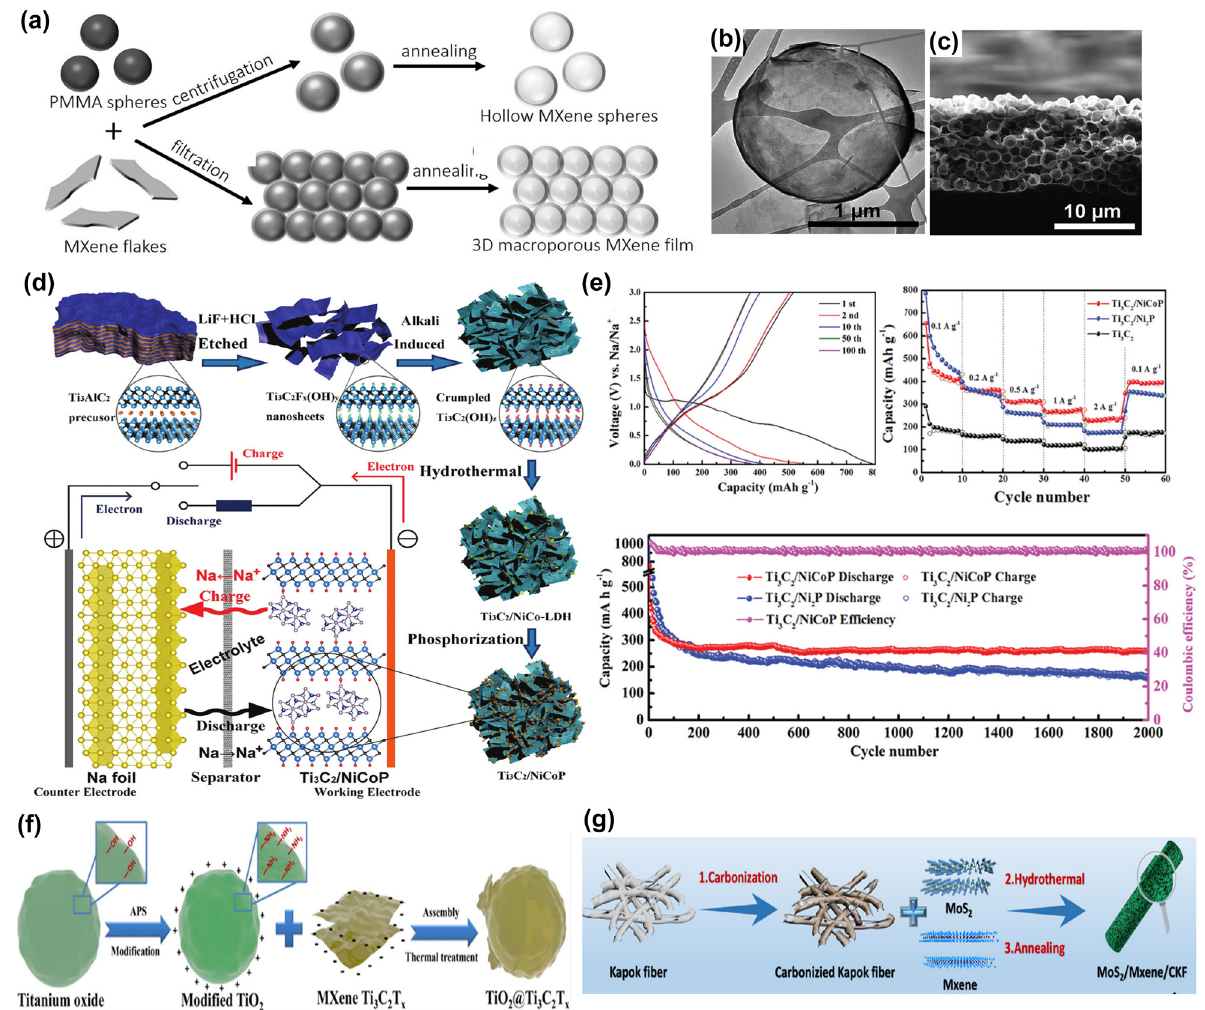
Figure 6: Preparation process, structure and electrochemical performance of MXene composites anode for SIBs. (a) Schematic showing the construction of hollow MXene spheres and 3D macroporous MXene frameworks. (b) A hollow Ti Cross-sectional SEM images of the 3D macroporous Ti Schematic illustration of the synthesis process of the Ti C /NiCoP electrode. Rate capability of the Ti profiles of the Ti 3 2 C /Ni P, and Ti C /NiCoP electrodes at a current density of 1.0 A g − 1 after 2000 cycles. Reproduced with permission [122]. Copyright 2019, Ti 3 2 2 3 2 The Royal Society of Chemistry. (f) Schematic illustration of the synthetic process for TiO from Reference [126]. Copyright 2018, Elsevier B.V. (g) Schematic diagram of the synthesis process for MoS Reproduced with permission [123]. Copyright 2021, Elsevier